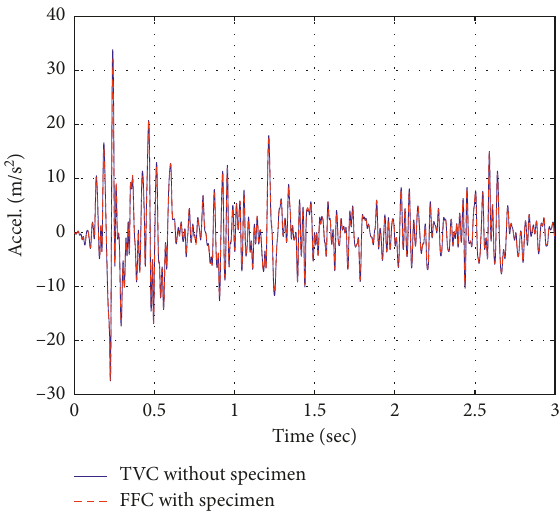
Figure 14: Acceleration time history of the dual shaking tables 12 . without/with specimen under